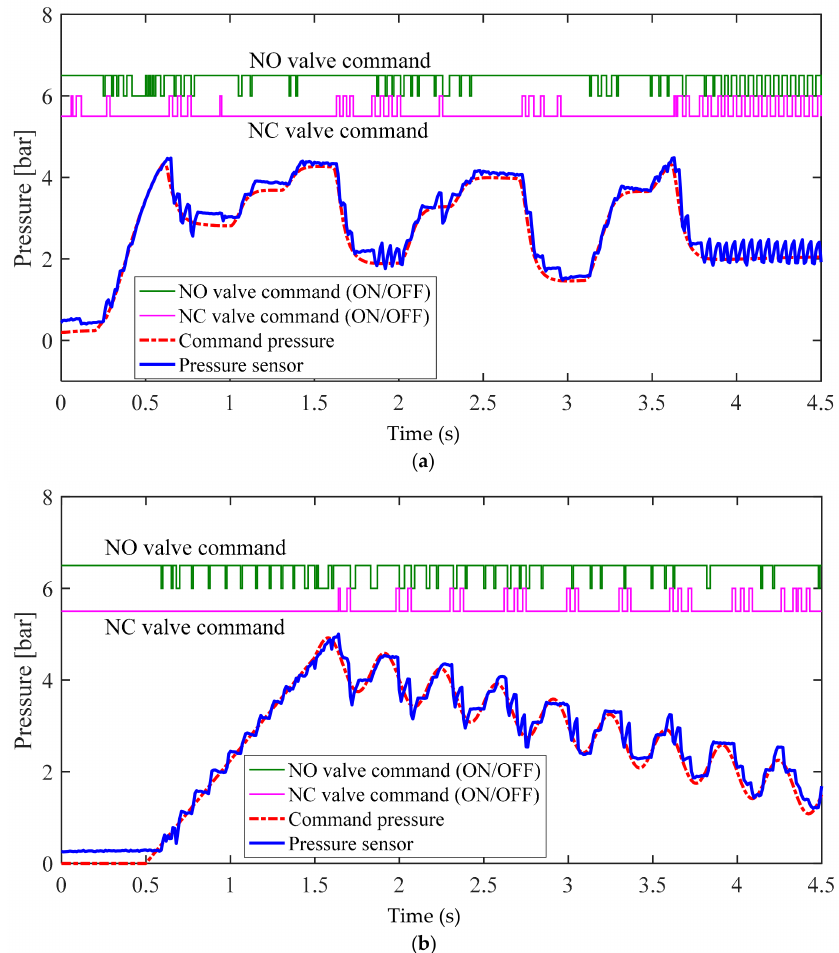
Figure 10. Experimental results for conventional pressure control method in the ( a ) normal braking case and the ( b ) anti-lock brake system (ABS) control